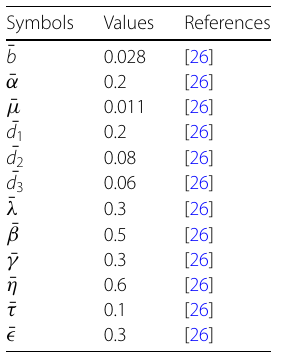
Table 1 Values and descriptions of the parameters (based on data [26]) Symbols